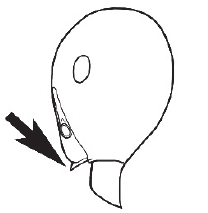
– If mandible of minor worker minutely striate with six or more teeth on masticatory margin, then major and media workers without above clypeal configuration (in similar species, anteromedial clypeal projection is directed